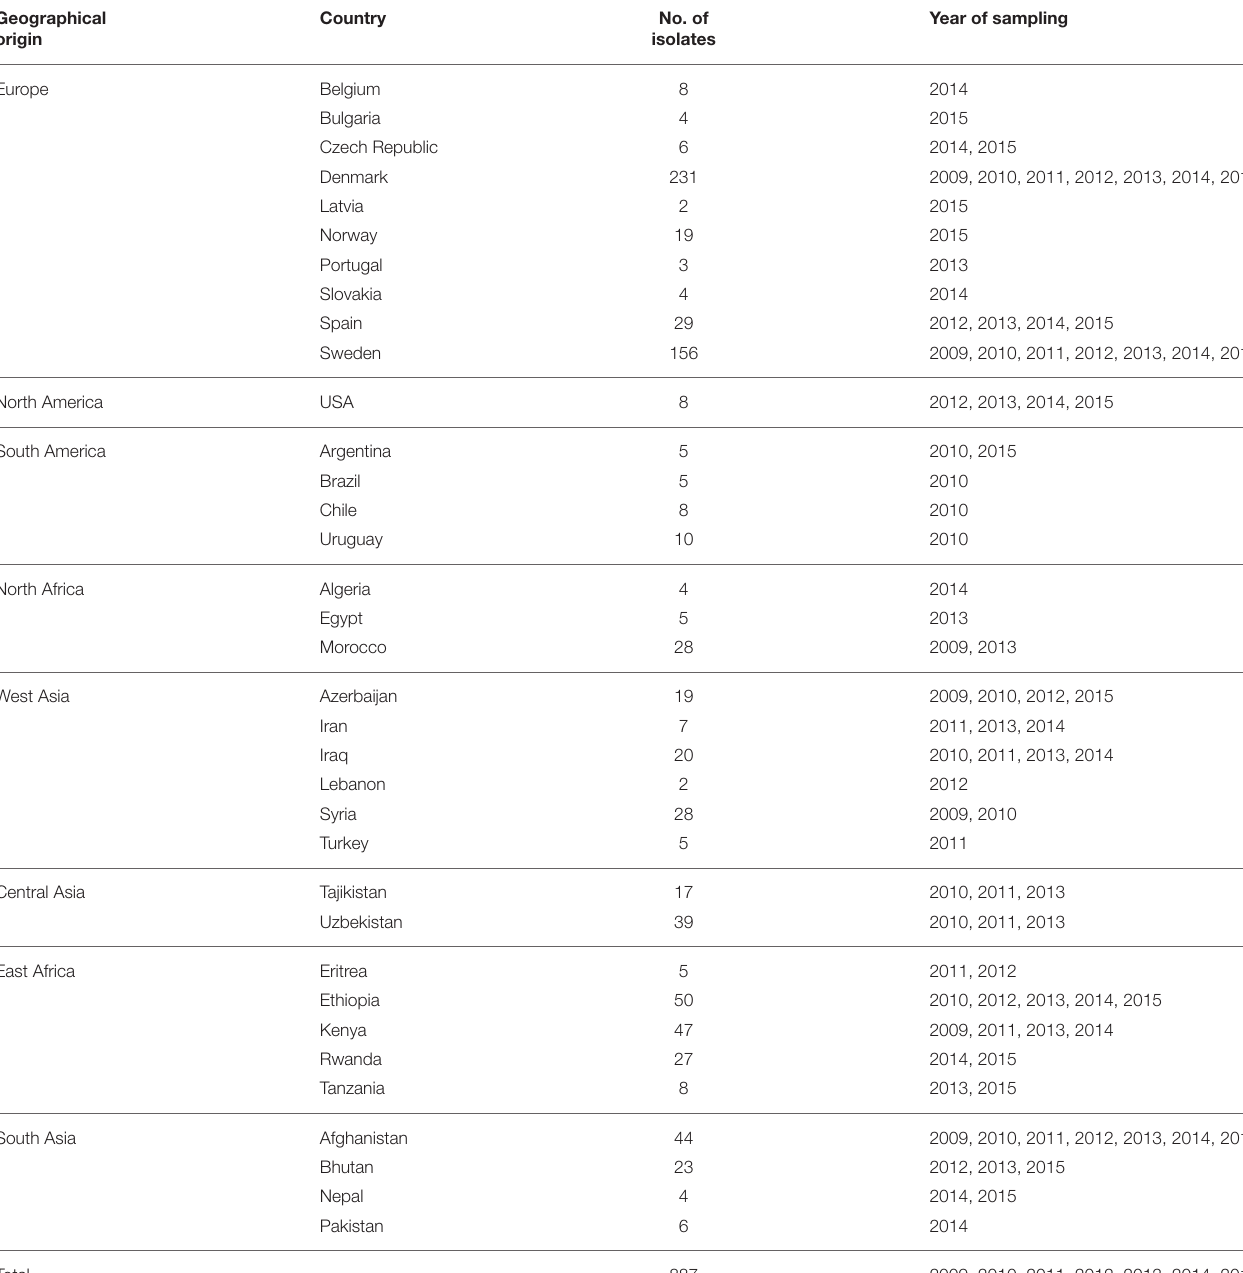
TABLE 1 | Worldwide P. striiformis isolates used to analyze virulence diversity and race divergence during 2009-2015. Geographical